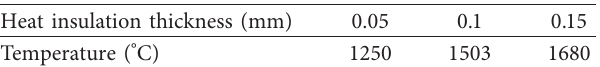
Figure 5: The model of electrothermal and static coupling simulation. Table 2: Temperature variation under different heat insulation